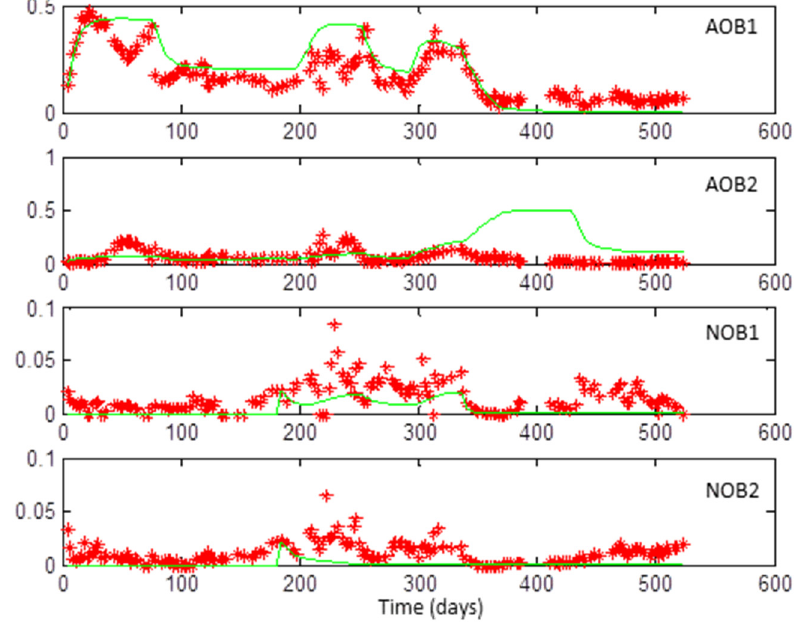
Figure 3. Simulations of model #2 (with the optimized set parameters given in Table 4) and measurements of species abundances for AOB1, AOB2, NOB1 and NOB2 (which correspond to peaks 38, 35, 5 and 9 from [31], respectively).